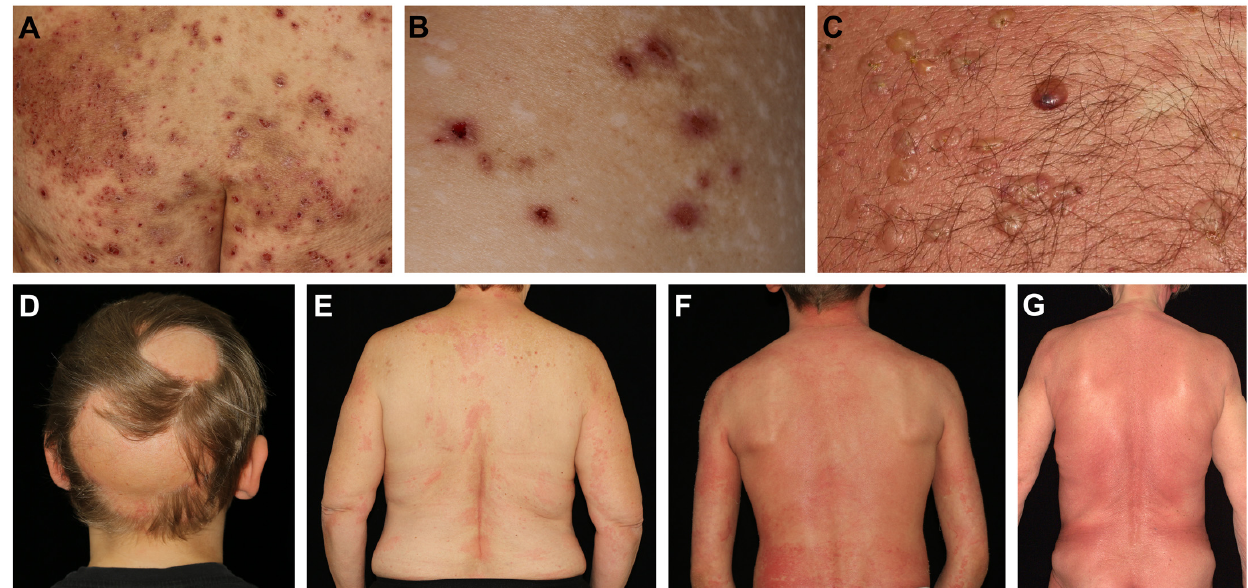
Figure 1. Clinical presentations of chronic inflammatory skin diseases with reports of effective dupilumab treatment. ( A ) Severe nummular eczema with confluent itchy and scaly plaques showing superficial excoriations. ( B ) Chronic prurigo presenting with intensely pruritic nodules that are developed and sustained by pathognomonic itch-scratch cycles. Deep scratching results in visible scars. ( C ) Tense clear or hemorrhagic blisters on reddish and infiltrated skin typically seen in bullous pemphigoid. ( D ) Nonscarring patchy hair loss on the scalp in a patient with alopecia areata. Progression can lead to total hair loss of the head (alopecia totalis, AT) or even the